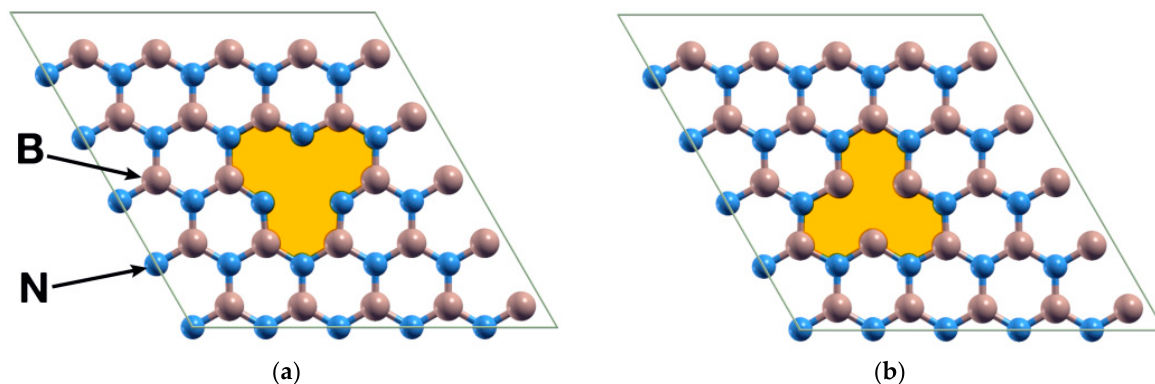
Figure 1. The two vacancies considered for the BN unit cell, originally containing 50 atoms: ( a ) The hBN surface with a boron atom removed; ( b ) The same surface but with a nitrogen atom removed. The figure presents the structures after a relaxation. We include the shaded areas for visualization purposes.